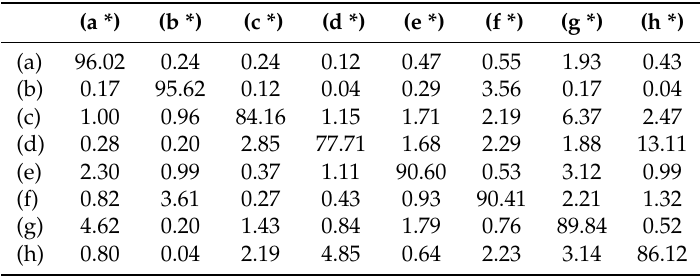
Figure 10. Deep Neural Network (DNN): the accuracy and loss graph of training dataset and validation dataset. ( a ) Binary classifier; ( b ) Multiclass classifier. Table 3. The confusion matrix of the DNN based multiclass classifier - Base classifier (*: Estimated class, Unit: %).